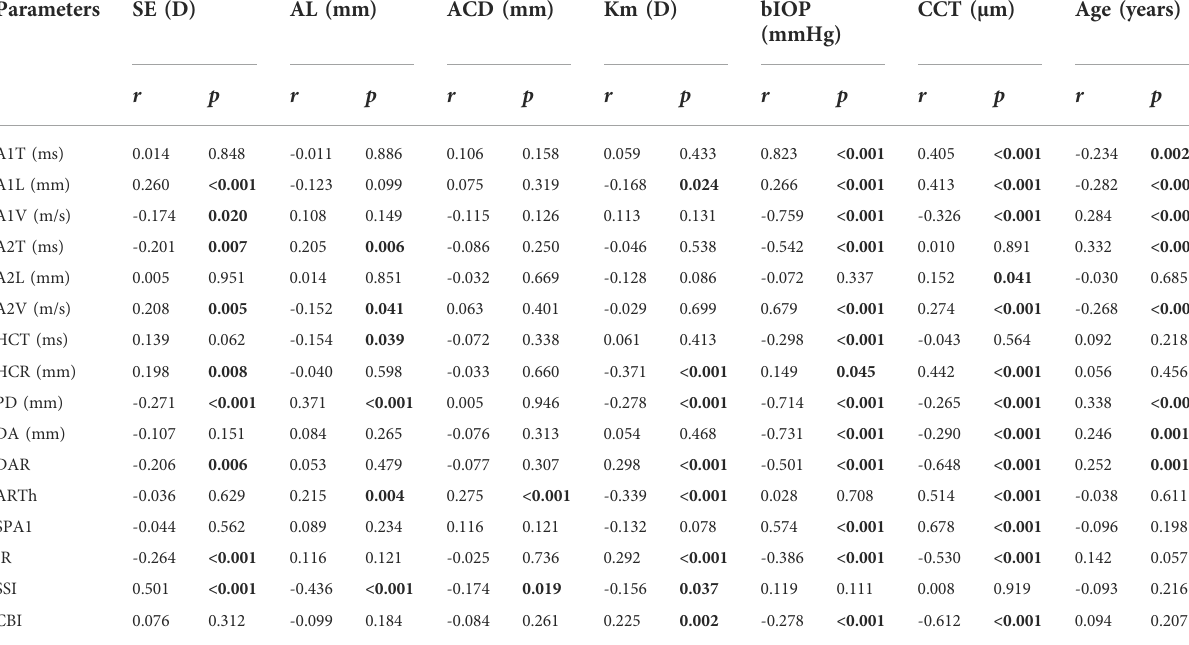
TABLE 1 Correlations between corneal biomechanical parameters and ocular biometric parameters.